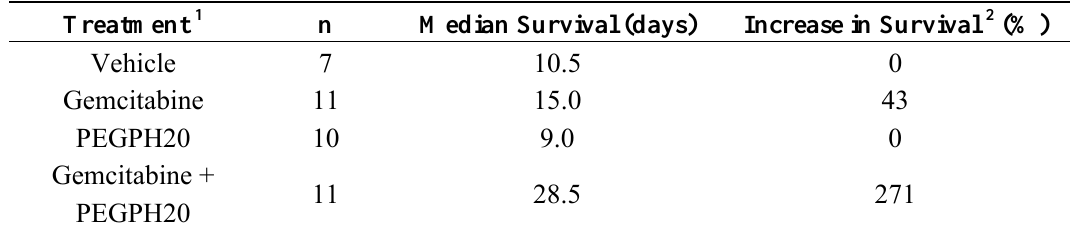
Table 1. Synergistic increase in survival by co-treatment of transgenic mouse model of PDA with PEGPH20 and gemcitabine